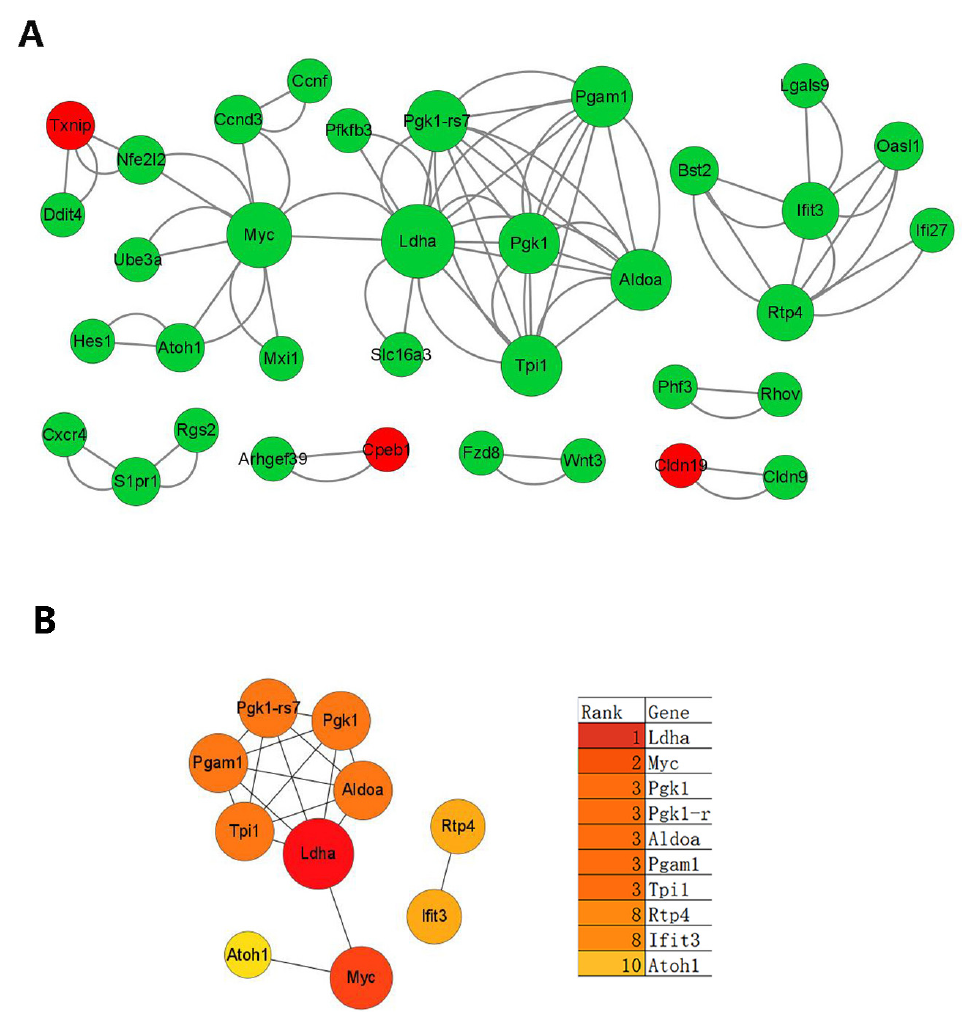
Figure 7. PPI network of DEGs. ( A ): Red represents upregulated genes while green represents downregulated genes and the nodes (proteins) with larger size have higher degree (number of interactions). ( B ): The top 10 hub genes are listed (color depth expressed degree height).